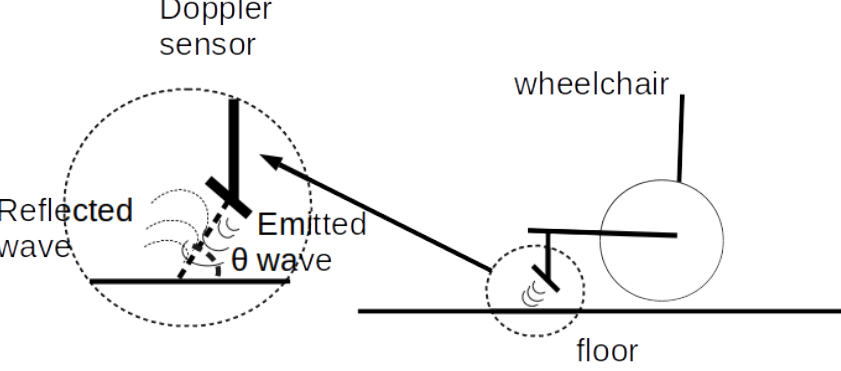
Figure 6. Working principle of the Doppler sensor installed in the